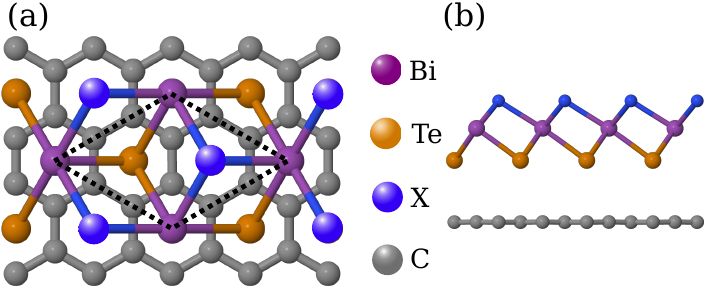
Figure 1. Top ( a ) and side ( b ) view of the BiTeX–graphene (X = I, Br, Cl) heterostructure. The black dashed line indicates the unit cell (color